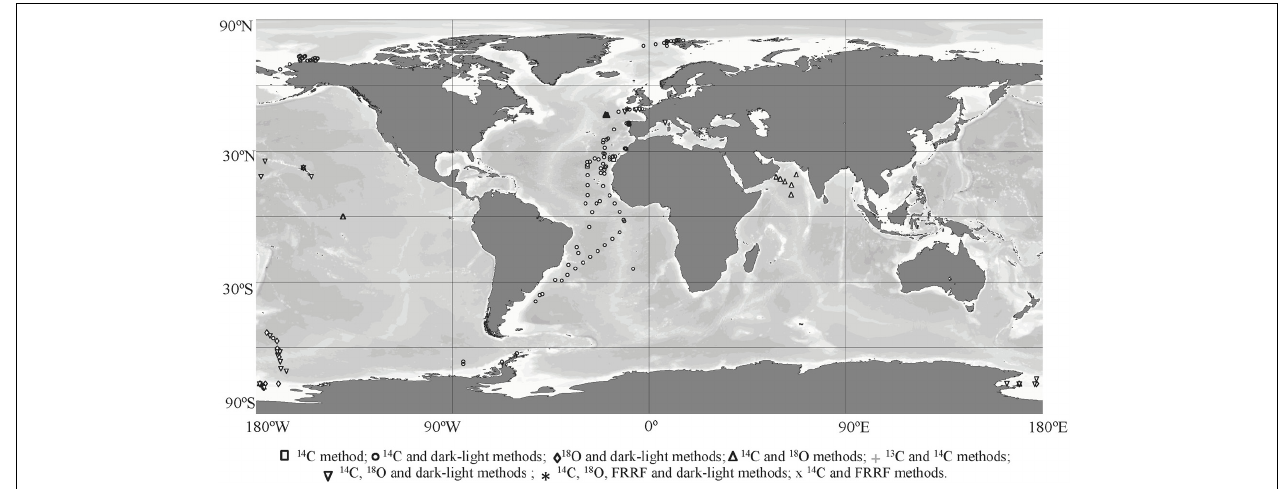
FIGURE 1 | Geographic distribution of the stations where the primary production has been evaluated by two different methods at least.